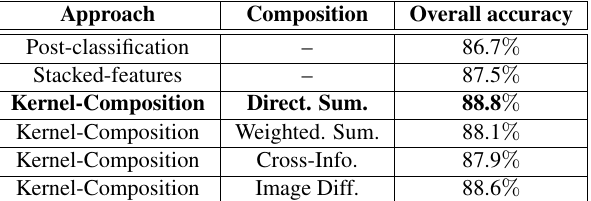
Figure 2: Landsat ETM+ image scenes, groundtruth and results Table 1: Approaches and overall